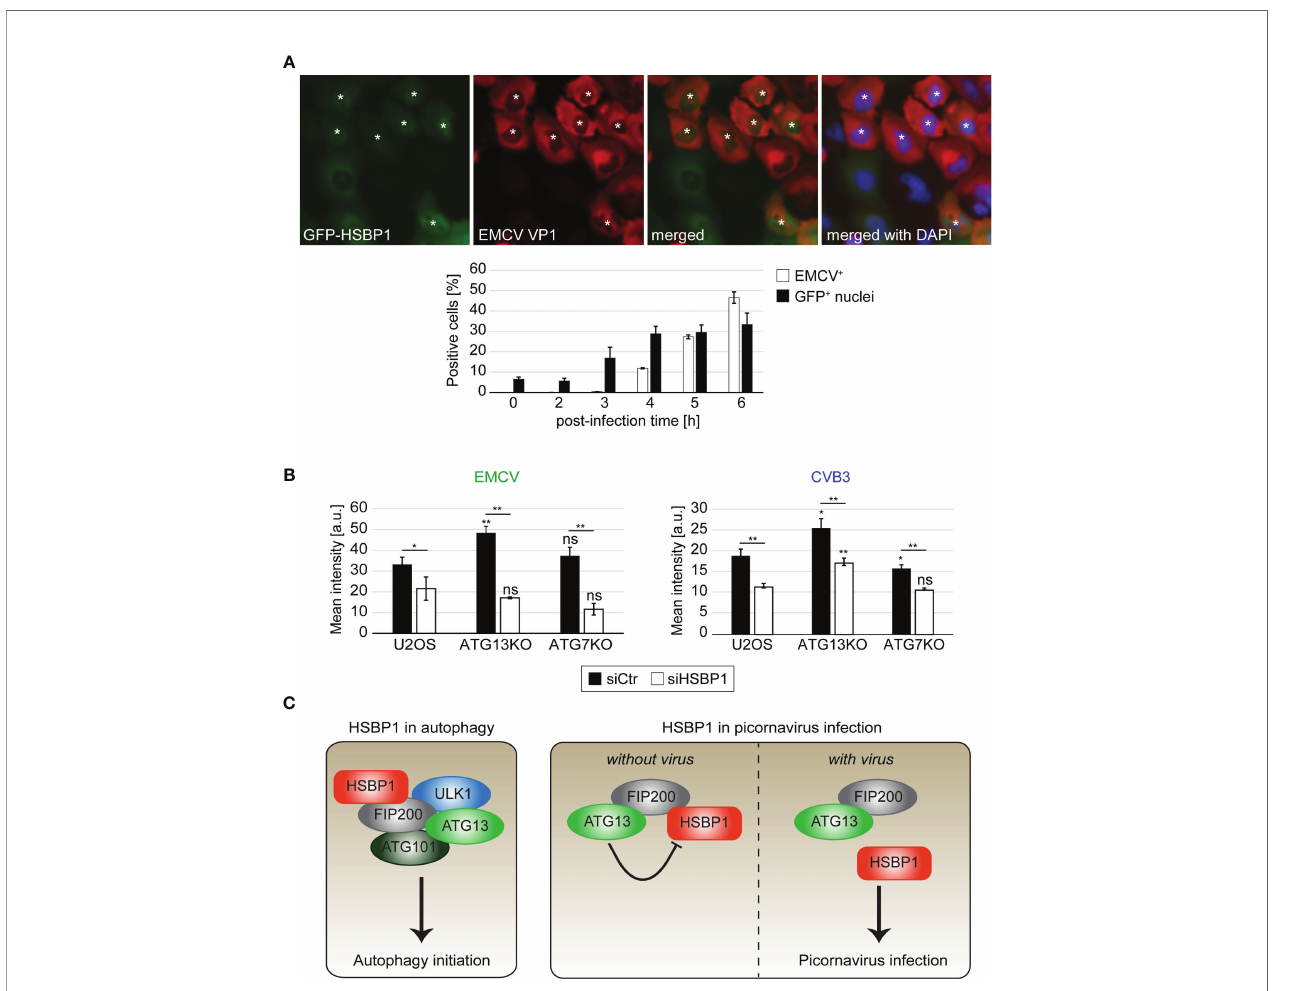
FIGURE 4 | HSBP1 counteracts the anti-picornaviral function of ATG13 and translocates to the nucleus upon infection. (A) GFP-HSBP1 U2OS cells were infected with EMCV for the indicated times before being fi xed and immunostained with anti-EMCV VP1 antibodies. IF images were automatically acquired and analyzed using the TissueFAXS microscope and software. EMCV VP1 positive cells (EMCV + ) and cells positive for GFP-HSBP1 signal in the nucleus (GFP + nuclei) were quanti fi ed. Error bars represent SDs of 3 independent experiments. White asterisks highlight GFP-HSBP1 U2OS cells with signal in the nucleus. (B) U2OS, ATG13KO and ATG7KO cells were transfected with either siCtr or siHSBP1 for 48 h, before being infected with EMCV (left panel) or CVB3 (right panel) for 6 h. Cells were immunostained using antibodies against EMCV and CVB3 VP1 to identify the infected cells and determine the degree of infection. The mean signal intensities were quanti fi ed and error bars represent SDs of 3 independent experiments. (C) Schematic model for the functions of HSBP1 in autophagy and picornavirus replication. The statistical signi fi cances were calculated to the controls. The symbols * and ** indicate signi fi cant differences of p < 0.05 and p < 0.01, respectively and ns indicate not signi fi cant. If not indicated otherwise, statistical differences were calculated to the control (U2OS